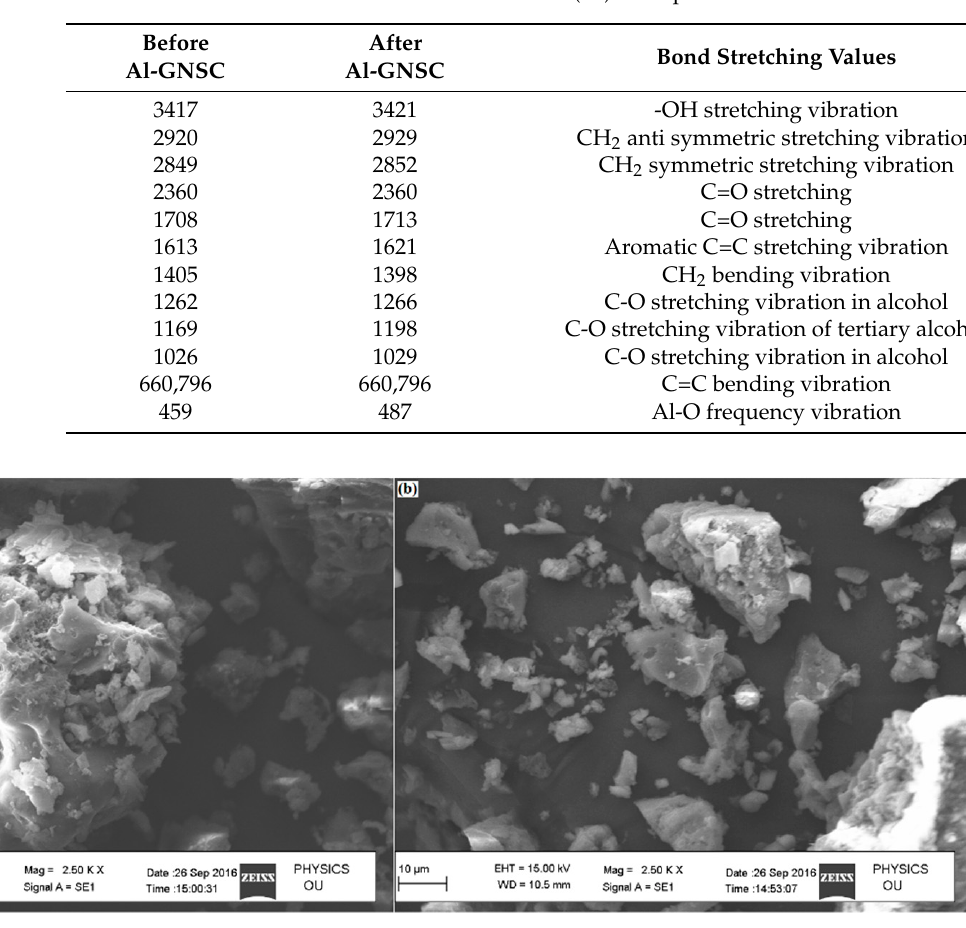
Figure 2. SEM Images of Al-GNSC: ( a ) before, and ( b ) after Cr(VI) adsorption.